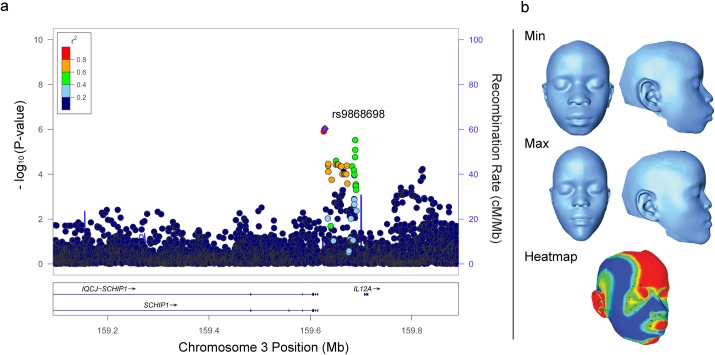
SCHIP1 locus associated with PC4.(A) Regional association plot of PC4 at the SCHIP1 locus. Association data are shown using GWAS P-values. The most associated SNP rs368386044 could not be displayed in the LocusZoom plot, but is in complete linkage disequilibrium with rs9868698. See Fig 3legend for details. (B) Morphs showing the range of shape variation along PC4. The heatmap depicts the regions of the face that vary the most between the min and max morphs. Red shows the regions that project most beyond the mean mesh at the positive extreme while yellow is intermediate in that direction. Blue shows the areas that project most inwards from the mean mesh while light blue shows a lesser degree of inwards projection. Green shows those regions that align most closely to the mean mesh.